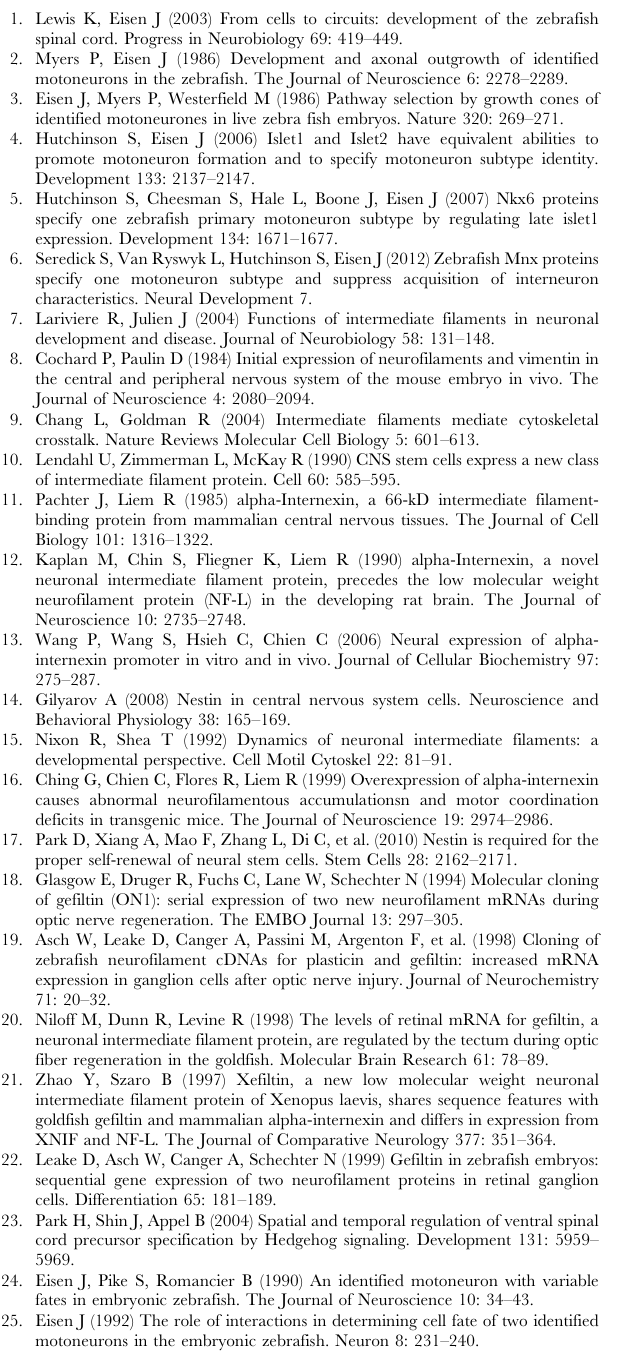
Table S1 Candidate genes, their Sequence IDs, and the magnitude and direction of their abundance in the